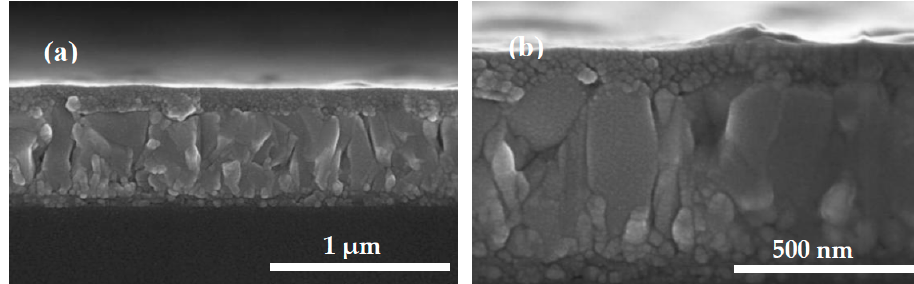
Figure 4. Cross-sectional SEM images of the TiO 2 /SnO 2 complementary composite hole blocking layer with SnO 2 spin-coated on compact TiO 2 -coated rough FTO at 3000 rpm: ( a ) Smaller magnification; ( b ) Larger magnification.